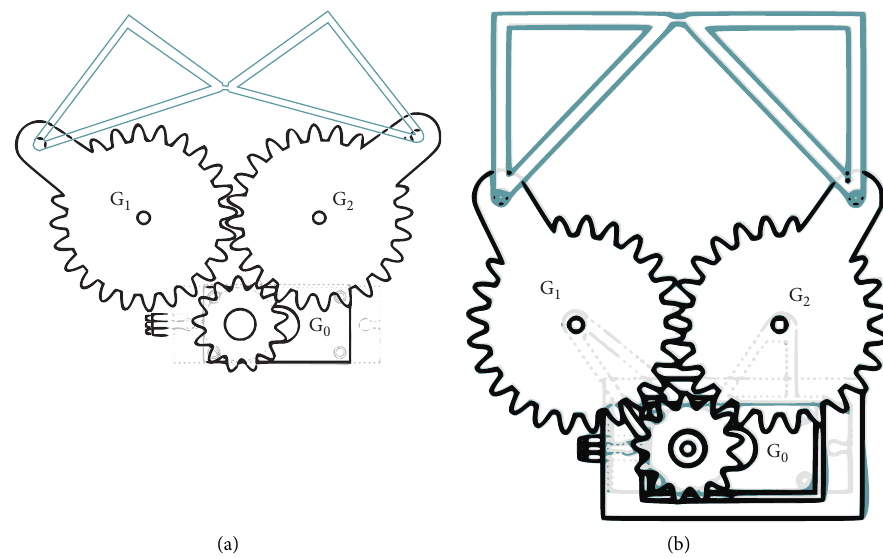
Figure 10: Movement generated by the gears to bend the